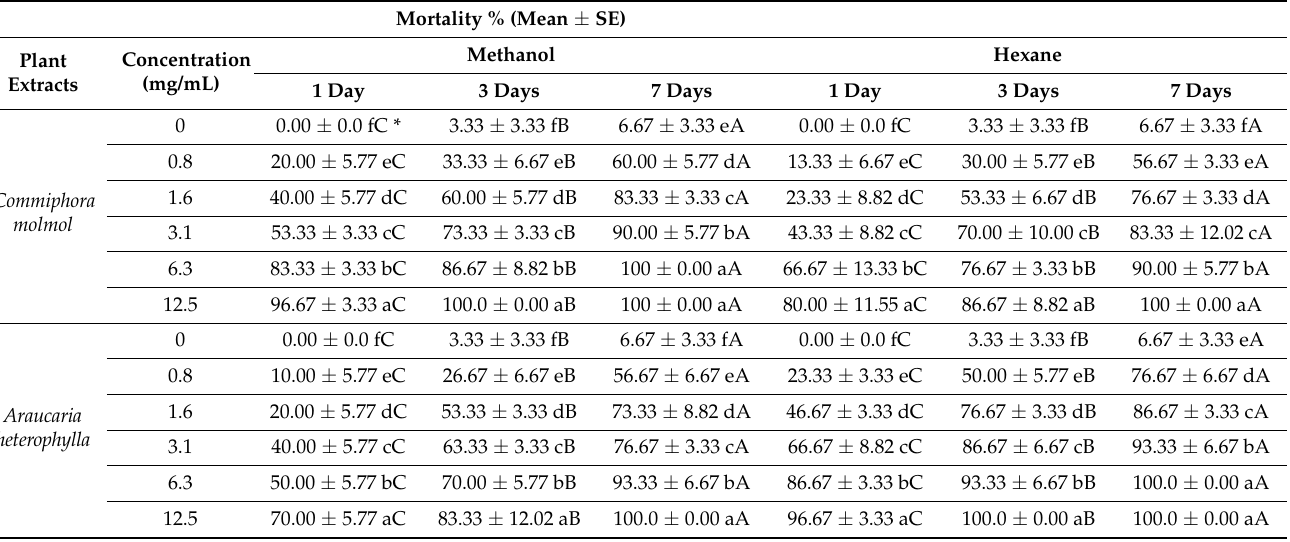
Table 7. Efficacy of the plant extracts of Commiphora molmol and Araucaria heterophylla against the cattle louse fly, Hippobosca maculata .